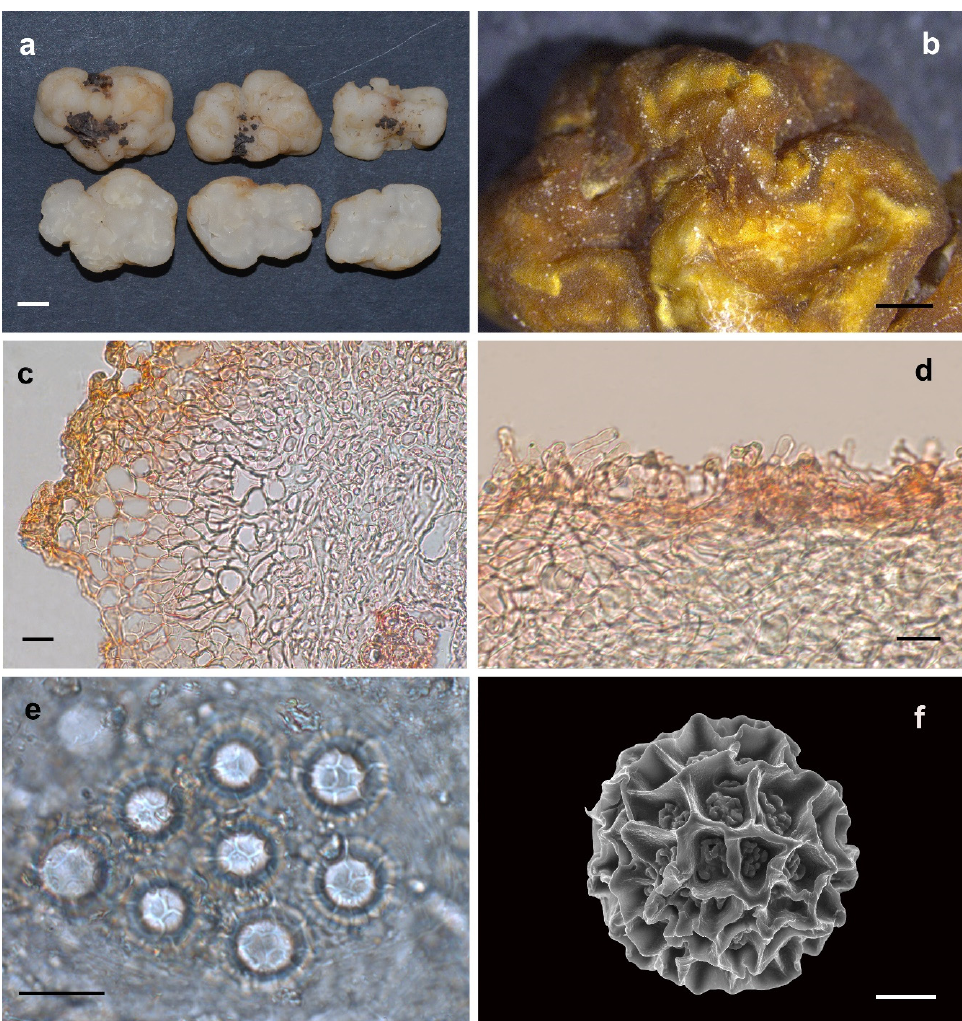
Figure 5. Hydnobolites lini (Holotype, YNAU0860). ( a ) Fresh ascomata and gleba; ( b ) dried ascoma;